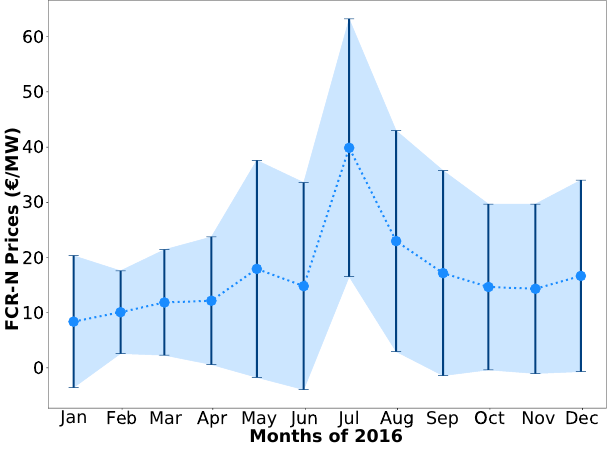
Figure 3. Average and variance for the FCR-N prices during the months of 2016.